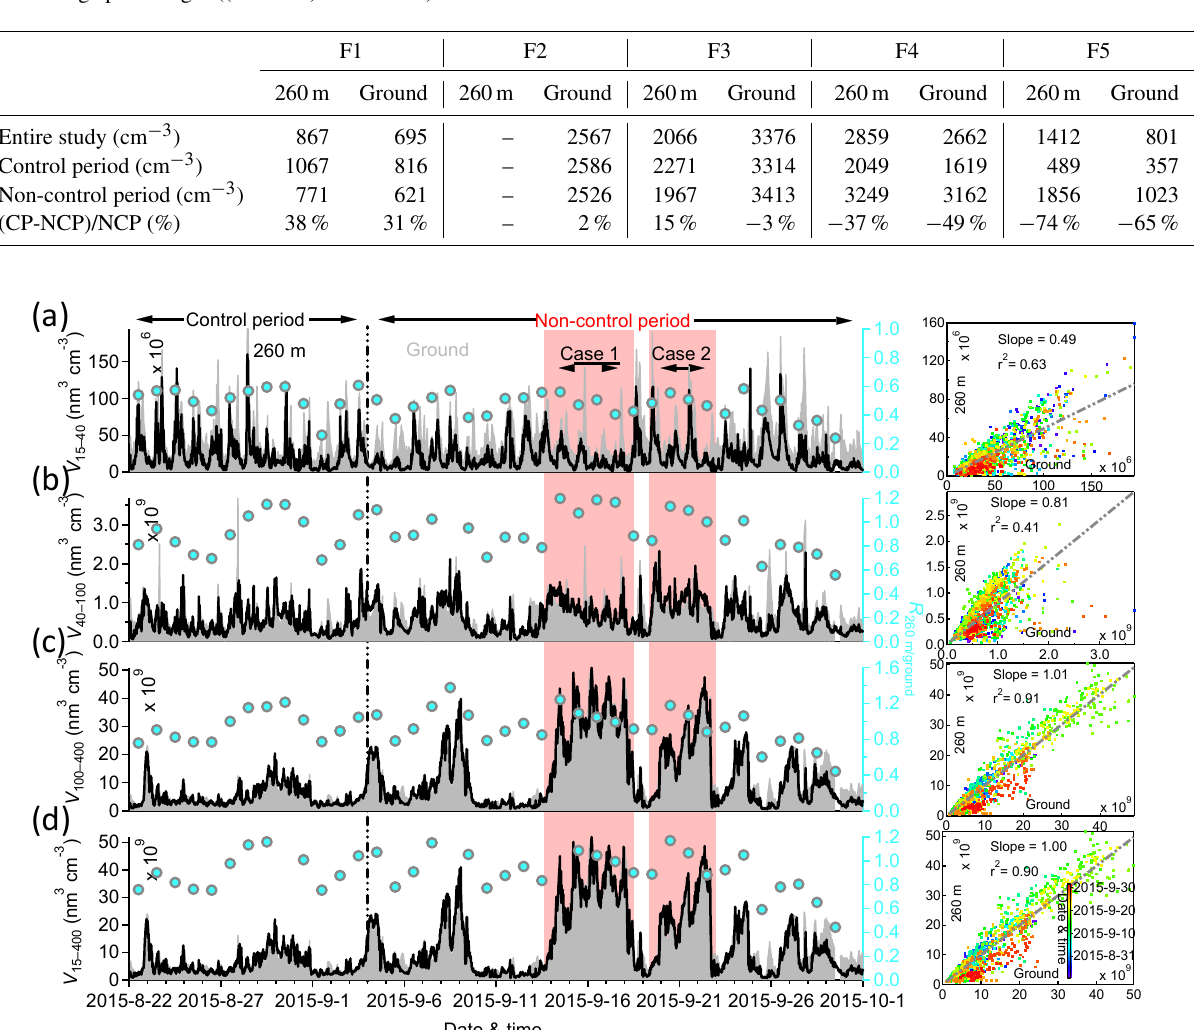
Table 2. Summary of average number concentrations of five factors for the entire study, control period (CP), non-control period (NCP), and also the change percentages ((CP-NCP)/NCP × 100).